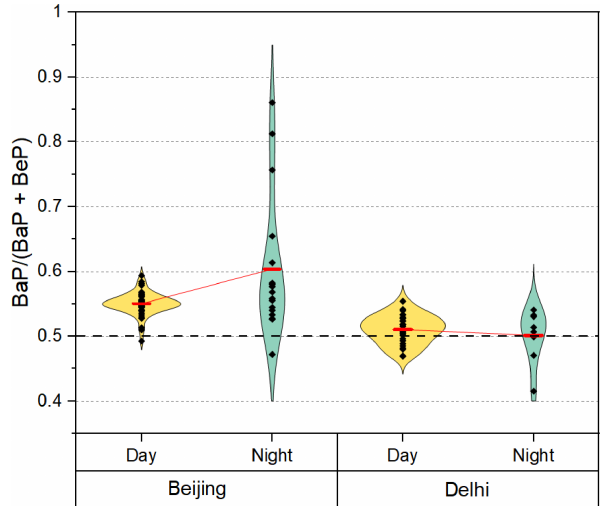
Figure 5. Ratio of BaP / (BaP + BeP) in PM 2 . 5 samples during the daytime (every 3h) and night-time (15h). Violin plots represent the data distribution between day and night, and the wider sections rep- resent the higher density of data smoothed by a kernel density es- timator. Red rectangle symbols represent the mean concentration, and the red lines connect the mean values between day and night.